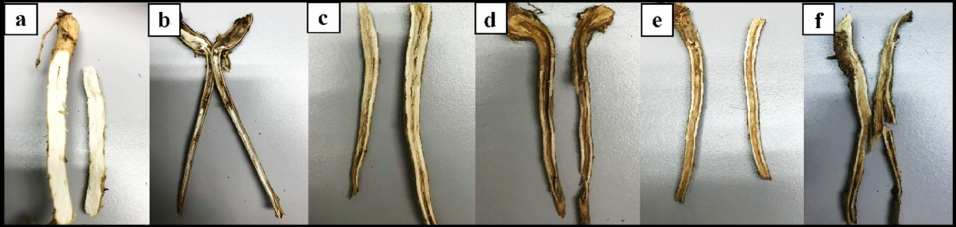
Figure 6. Examples of below-ground symptoms on rubber seedlings after six months of treatments with ( a ) T1, a plant without any pretreatment and Rigidoporus microporus inoculation (the negative control); ( b ) a T2, plant inoculated with Rigidoporus microporus but without any pretreatment (the positive control); ( c ) T3, a plant pretreated with Trichoderma asperellum and inoculated with Rigidoporus microporus; ( d ) T4, a plant pretreated with Trichoderma spirale and inoculated with Rigidoporus microporus; ( e ) T5, a plant pretreated with the combination (Trichoderma asperellum + Trichoderma spirale) and inoculated with Rigidoporus microporus; and ( f ) T6, a plant pretreated with propiconazole and inoculated with Rigidoporus microporus. Table 11. Disease severity index (DSI) of rubber seedlings based on above- and below-ground symptoms and the efficacy of Trichoderma suspensions ( Trichoderma asperellum + Trichoderma spirale ) or propiconazole fungicide in the suppression of white root rot disease caused by Rigidoporus microporus